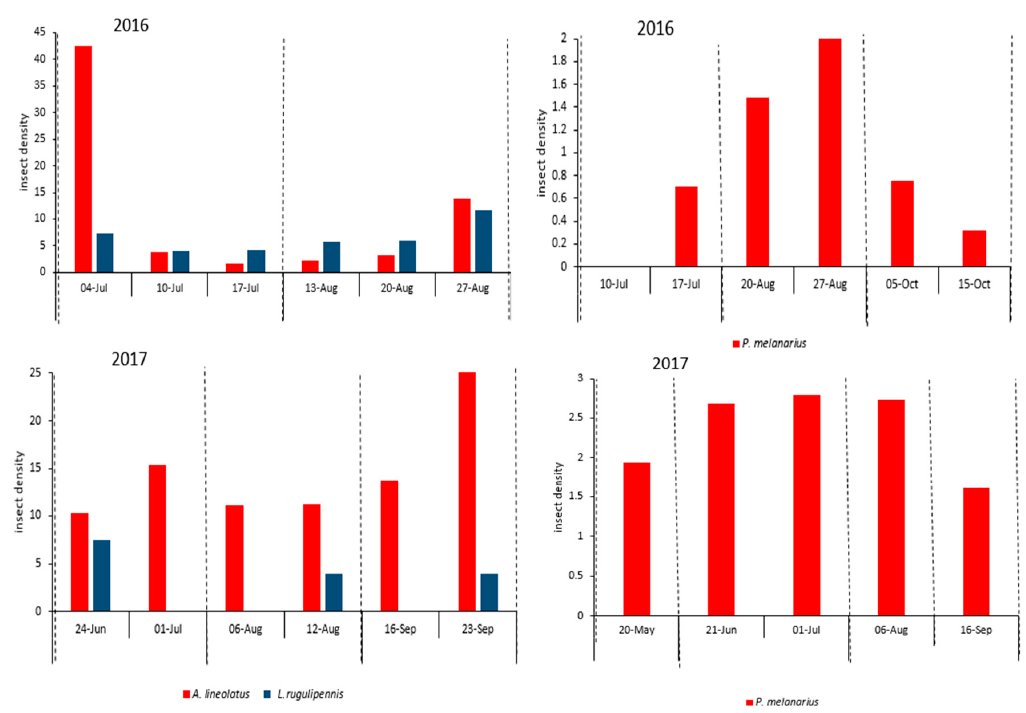
Figure 2. Temporal dynamics of the plant bugs Lygus rugulipennis and Adelphocoris lineolatus (left) and carabid Pterostichus melanarius (right) in the studied alfalfa fields in the first, second, third, and fourth weeks after harvest (dashed lines indicate alfalfa harvest times). Plant bugs and carabid were sampled using sweep nets and pitfall traps, respectively.